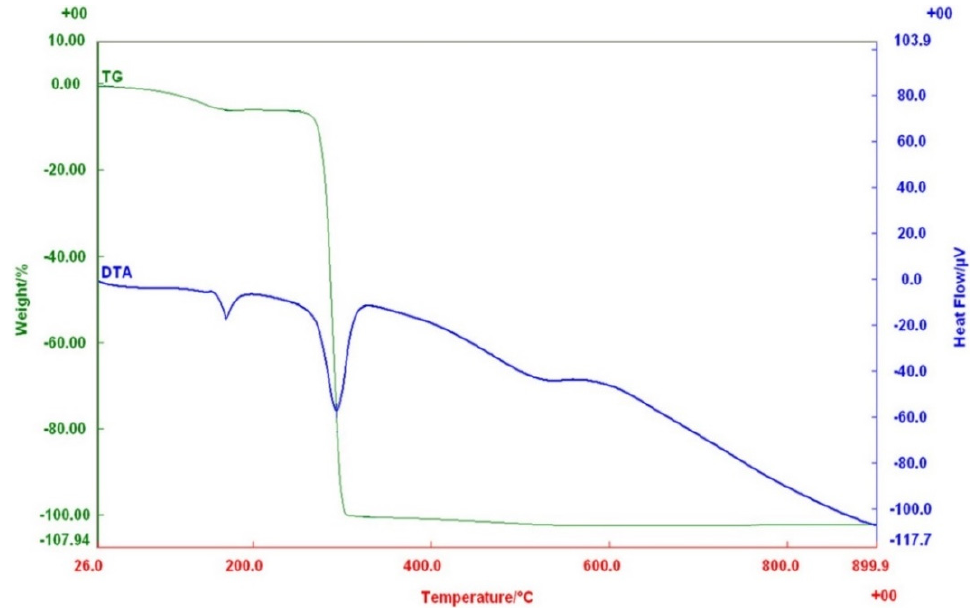
Figure 8. TG/DTA thermogram of PHB biosynthesized by Priestia sp. strain JY310 under nitrogen atmosphere.